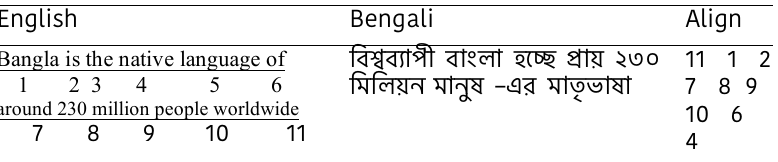
Table 1 Example word-aligned parallel